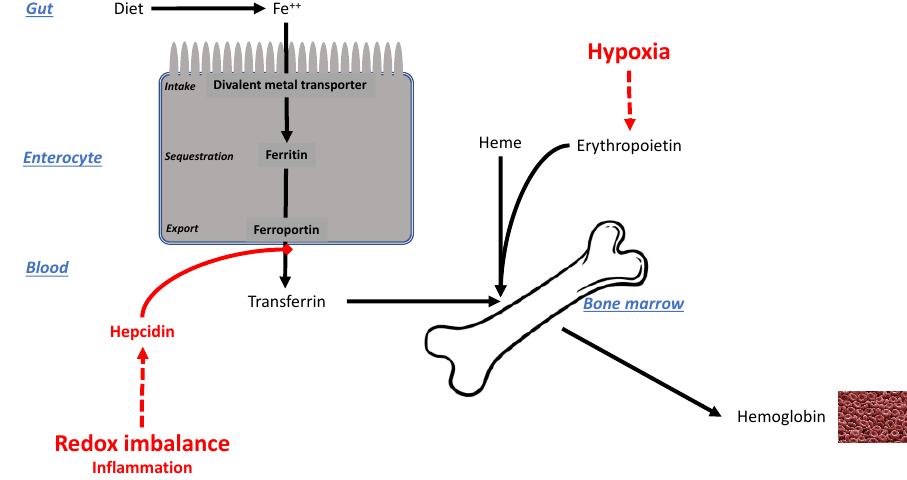
Figure 7. Scheme of iron handling and the impact of hypoxia and inflammation.